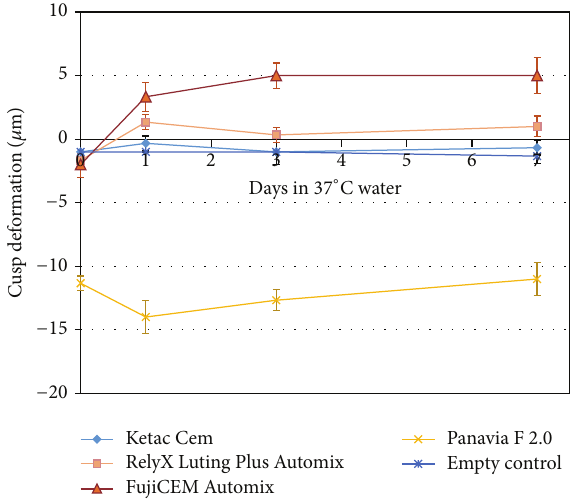
Figure 7: Cuspal deformation during curing and after days of immersion in 37 ∘ C water: short-term shrinkage versus longer-term expansion of cements.